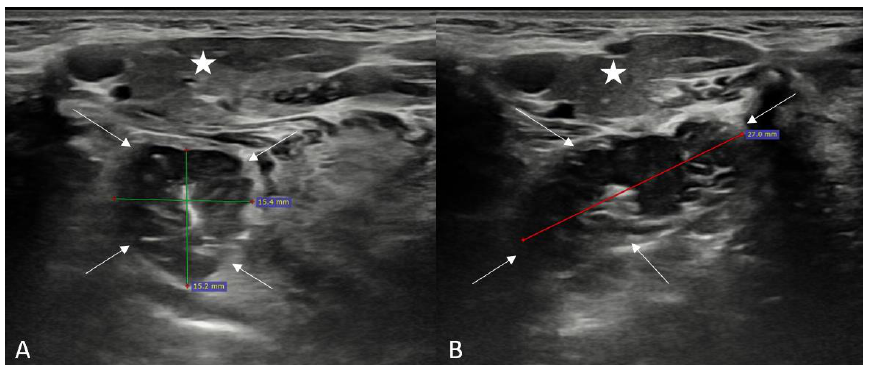
Figure 1. Ultrasonographic evaluation and measurements of the palatine tonsil in a healthy partici- pant (Asterisk: Submandibular gland, Arrows: Palatine tonsil). ( A ): Transverse plane, ( B ): Longitu- dinal plane.